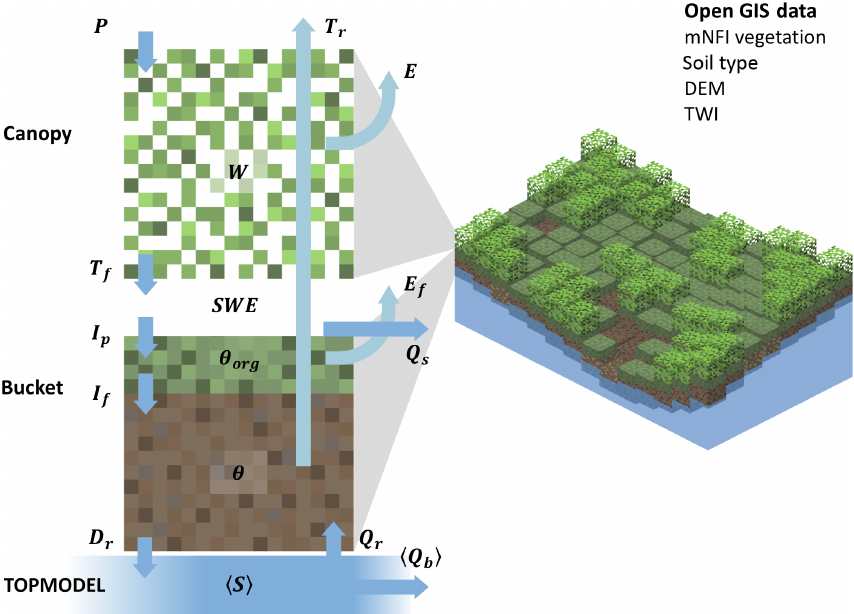
Figure 1. Structure of SpaFHy. At each grid cell, aboveground and topsoil hydrology is solved by Canopy and Bucket submodels whereas the lumped TOPMODEL is used to model saturated zone. The arrows correspond to interfacial fluxes: P precipitation; T f throughfall to virtual snowpack; I p potential infiltration to organic layer; I f infiltration to root zone; D r drainage to saturated zone; E evaporation or sublimation of canopy storage; E f evaporation from ground; T r transpiration; Q r return flow; Q s surface runoff; (cid:104) Q b (cid:105) baseflow.